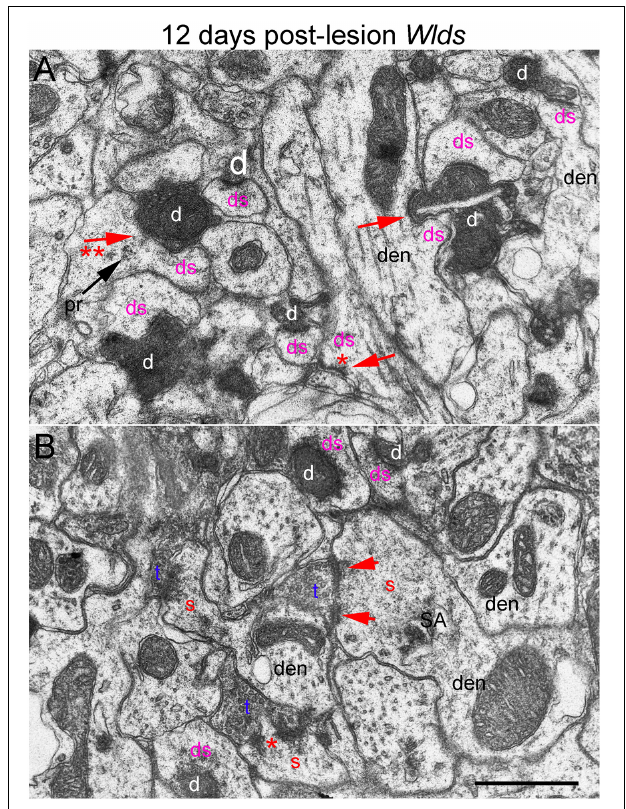
FIGURE 8 | Ultrastructural abnormalities of synapses at 12 days post-lesion in Wld s mice. (A) Synaptic terminals exhibiting dark-dense degeneration and collapsed spines at 12 days post-lesion in Wld s mice. Note slit in the large dark-dense terminal on the center right. Arrow with 2 asterisks indicates spine with segmented PSD and polyribosomes (pr) contacted by a degenerating presynaptic terminal. (B) Large complex spines with segmented PSDs (short arrows) and spinule (asterisk). Red s (red), spine head; t (blue), non-degenerating synaptic terminal; d (white) degenerating synaptic terminal; ds (purple) spine contacted by degenerating presynaptic terminal; den, dendrite; pr, polyribosomes. Calibration bar in (A) = 0.25 µ m and applies to (A,B)